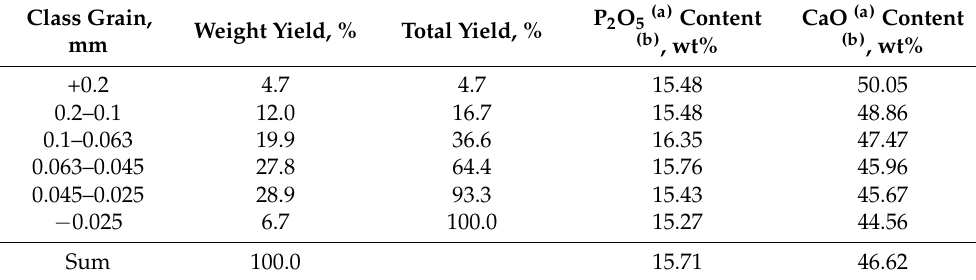
Table 8. Dry grain analysis results, and phosphorus and calcium contents in separated fractions.